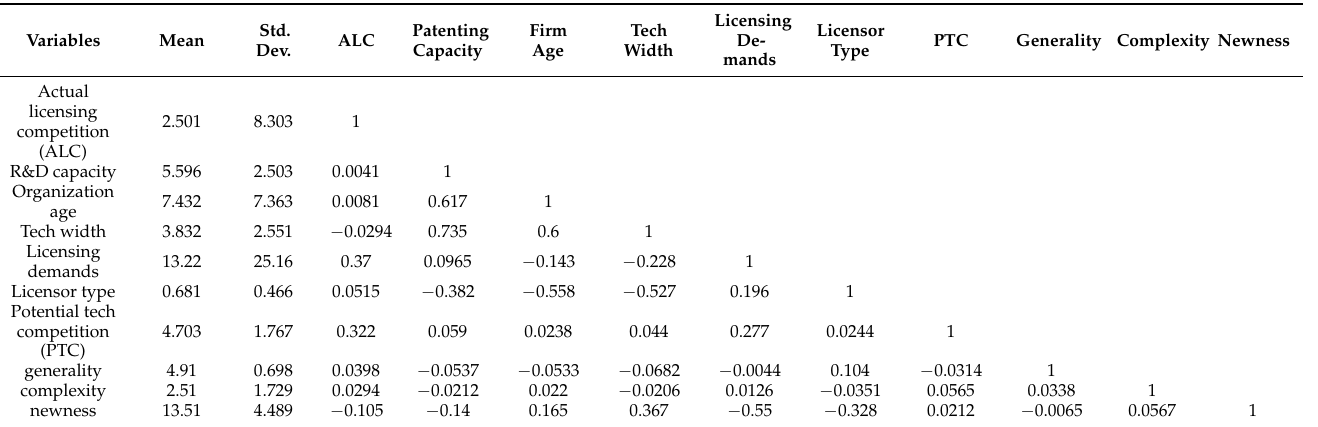
Table 1. Descriptive statistics and